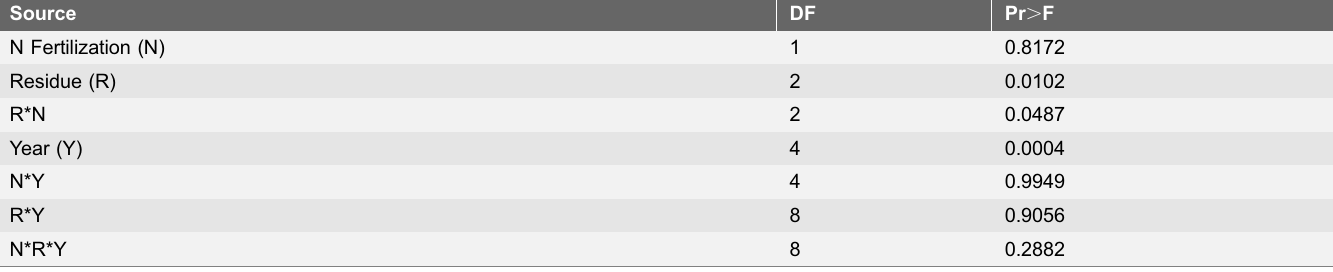
Table 5. Analysis of variance for soil organic C as affected by N fertilization, residue return, and their interaction in 2008, 2009, 2010, 2011, and